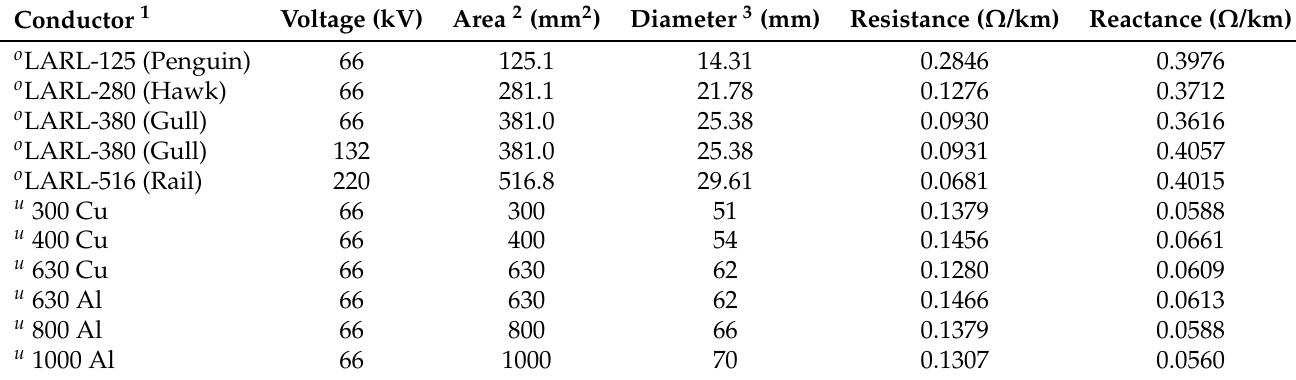
Table 4. Principal characteristics of existing transmission lines considered in the study.